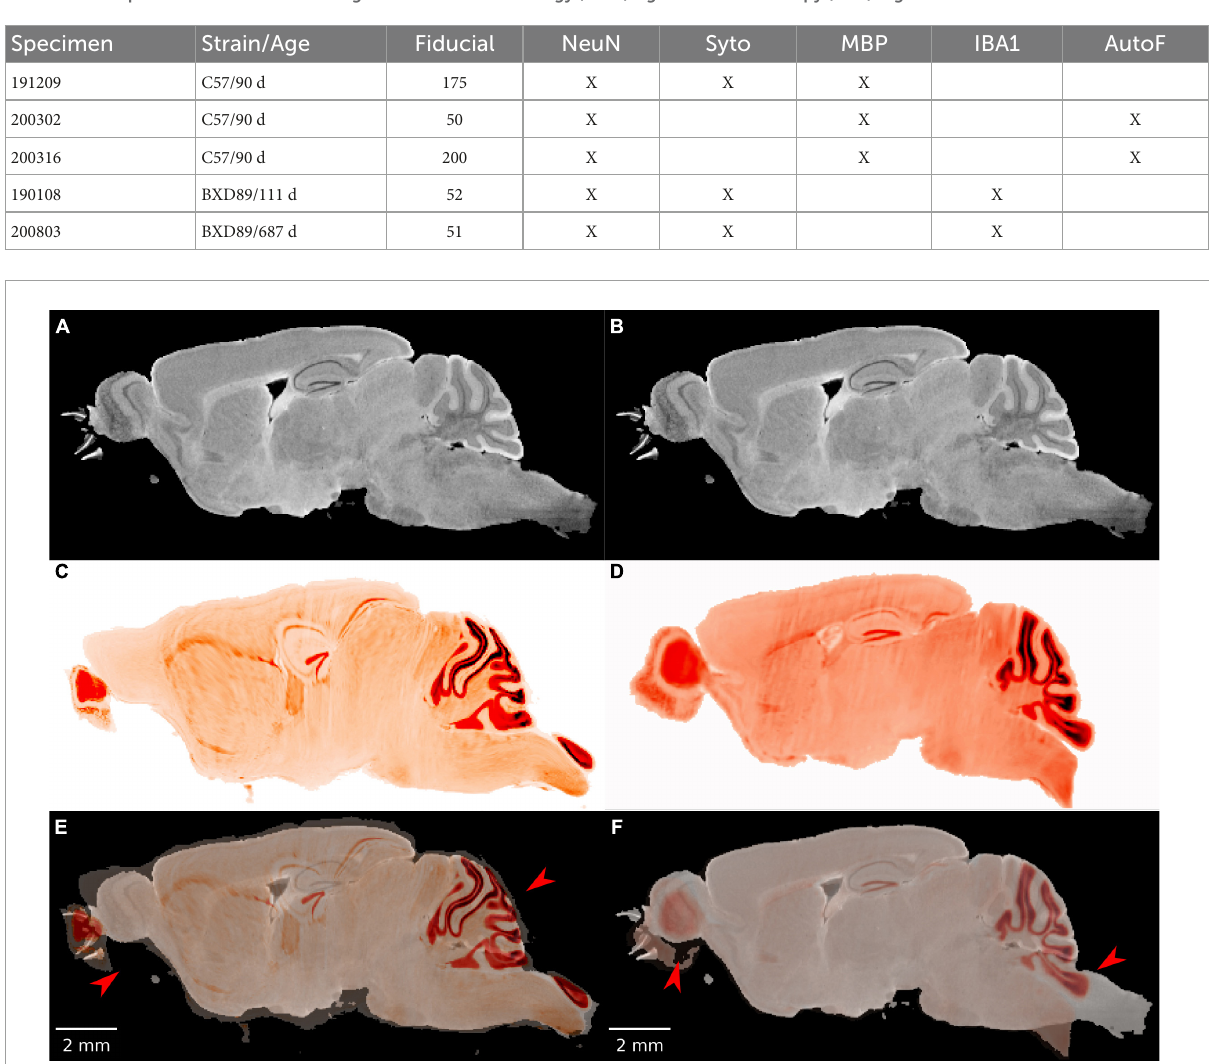
FIGURE2 The failure of existing registration algorithms in the cerebellum and olfactory bulb. (A,B) DWI; (C,D) NeuN image after registration; (E,F) overlaid DWI/NeuN (specimen 191209). The left hand column shows the result of Elastix (Klein et al., 2010) with rigid and b-spline registration and default settings. The registration errors in the olfactory bulb and brain stem are reduced but the errors in the dentate gyrus and cerebellum are significant (arrows in panel E ). The right hand column shows the result of ANTs (Avants et al., 2008) with affine and SyN and default settings. There is a reasonable overlap in the dentate gyrus but significant mismatch in the cerebellum and olfactory bulb (arrows in panel F